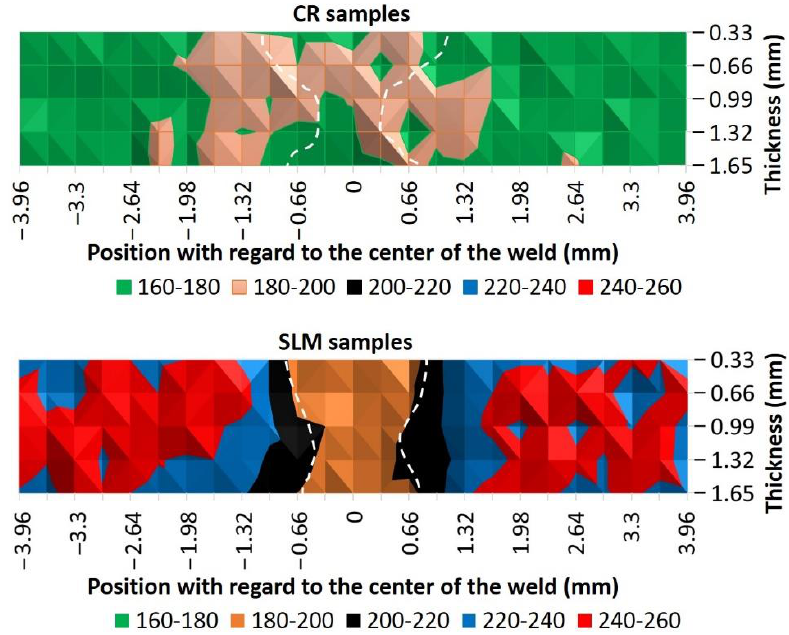
Figure 6. Cross-section hardness evolution of welded samples. Dashed lines correspond to the limit of the fusion zone.